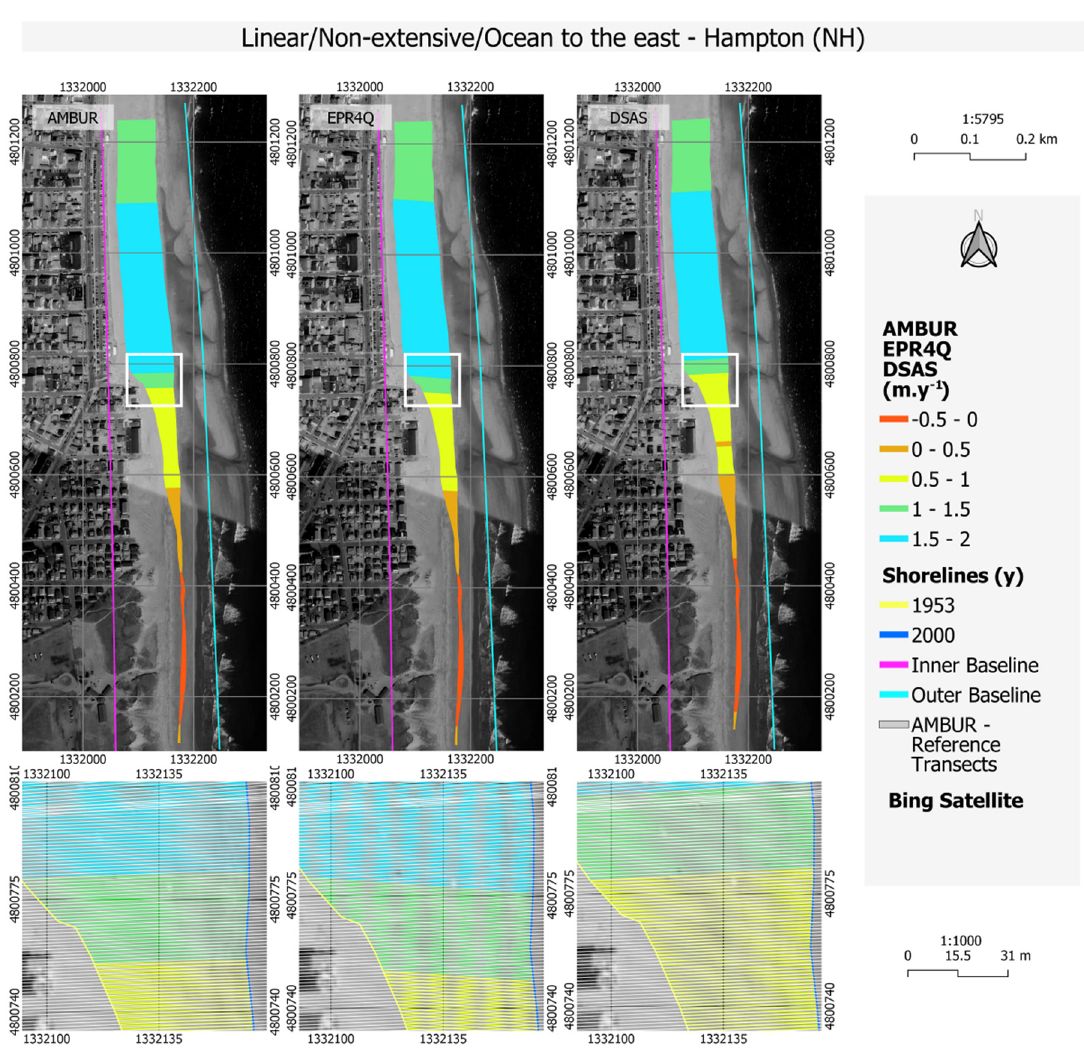
Figure 11. Shoreline changes in Hampton using the AMBUR, EPR4Q, and DSAS tools. White box shows in detail the tools results with the reference transects (AMBUR no filtered transects).